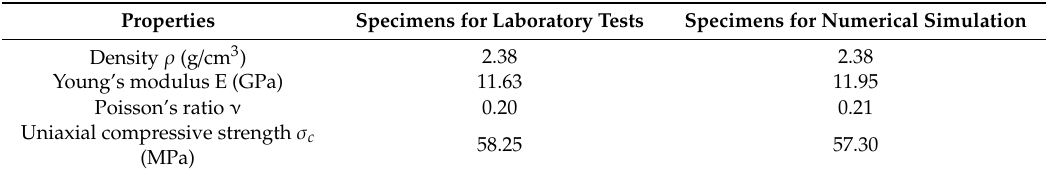
Table 2. Physico-mechanical parameters of intact cement mortar specimens for laboratory tests and numerical simulations .